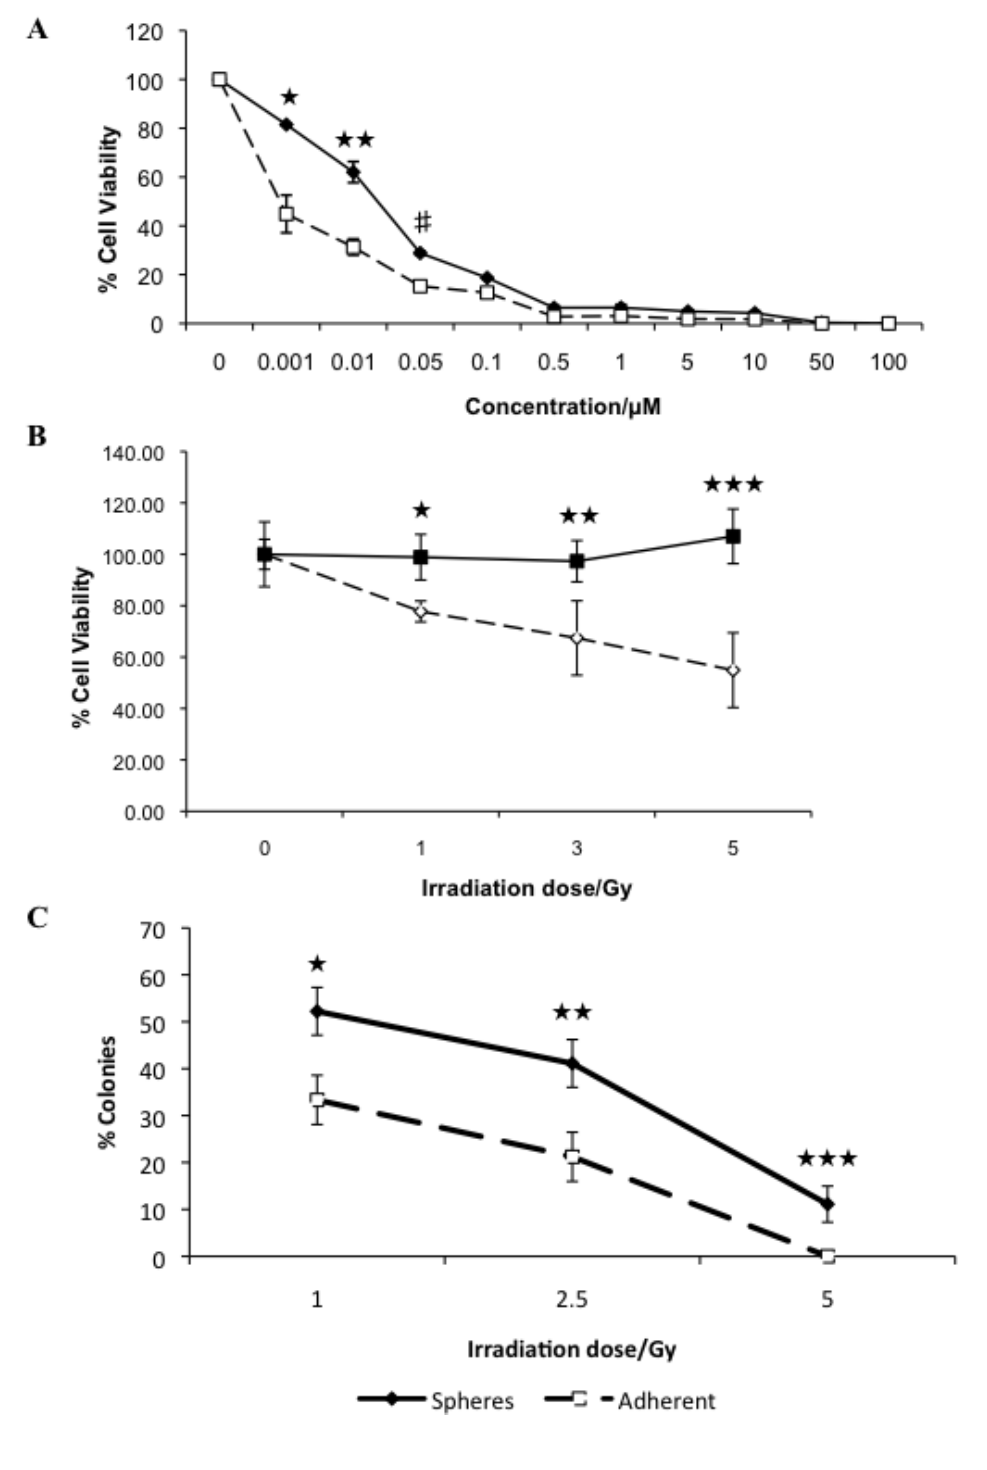
Figure 2. Tumorspheres exhibit increased resistance to conventional chemo- and radiation therapies. Adherent cells and tumorspheres were treated with increasing concentrations of doxorubicin and cell viability was assayed 72 hours post-treatment ( ★ p = 0.008; ★★ p = 0.038; ♯ p < 0.001) (A). Radiation sensitivity was determined by assaying for cell viability 72 hours post-treatment ( ★ p = 0.003; ★★ p = 0.026; ★★★ p = 0.002) (B) and by determining colony forming ability ( ★ p = 0.01; ★★ p = 0.009; ★★★ p < 0.001)